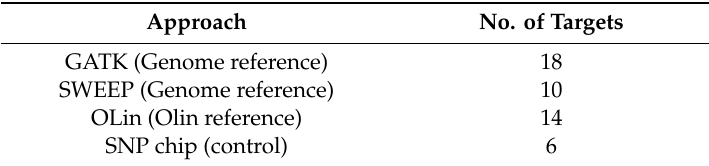
Table 1. Summary of target selection from di ff erent approaches for the Fluidigm experiment (targets selected from GATK, filtered through SWEEP, OLin as reference and SNP chip as